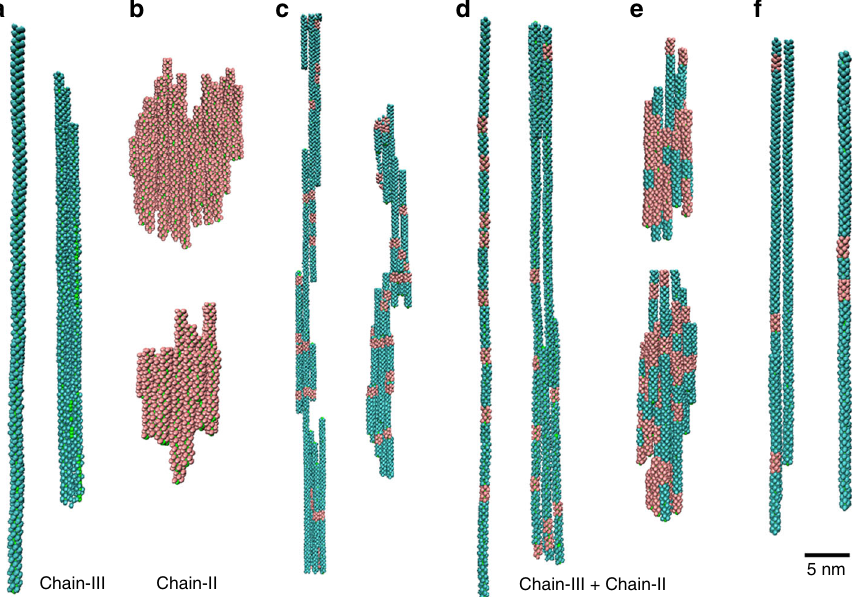
Fig. 9 Typical snapshots for the assembly in different systems. a Pure chain-III system; b pure chain-II system; c the chain-III and chain-II are mixed as the ratio of 4:1 in the presence of NO 3 − ; d the chain-III and chain-II are mixed as the ratio of 4:1 in the absence of NO 3 − ; e the chain-III and chain-II are mixed as the ratio of 1:1 in the presence of NO 3 − ; f the chain-III and chain-II are mixed as the ratio of 16:1 in the presence of NO 3 − . The ochre beads in the R -pempH − / R -pempH 2 molecules are not shown for clarity